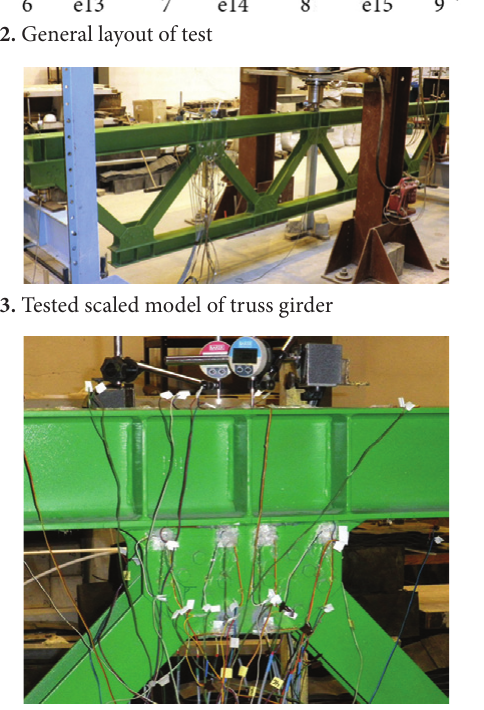
Fig. 14. Analysed joint – side view